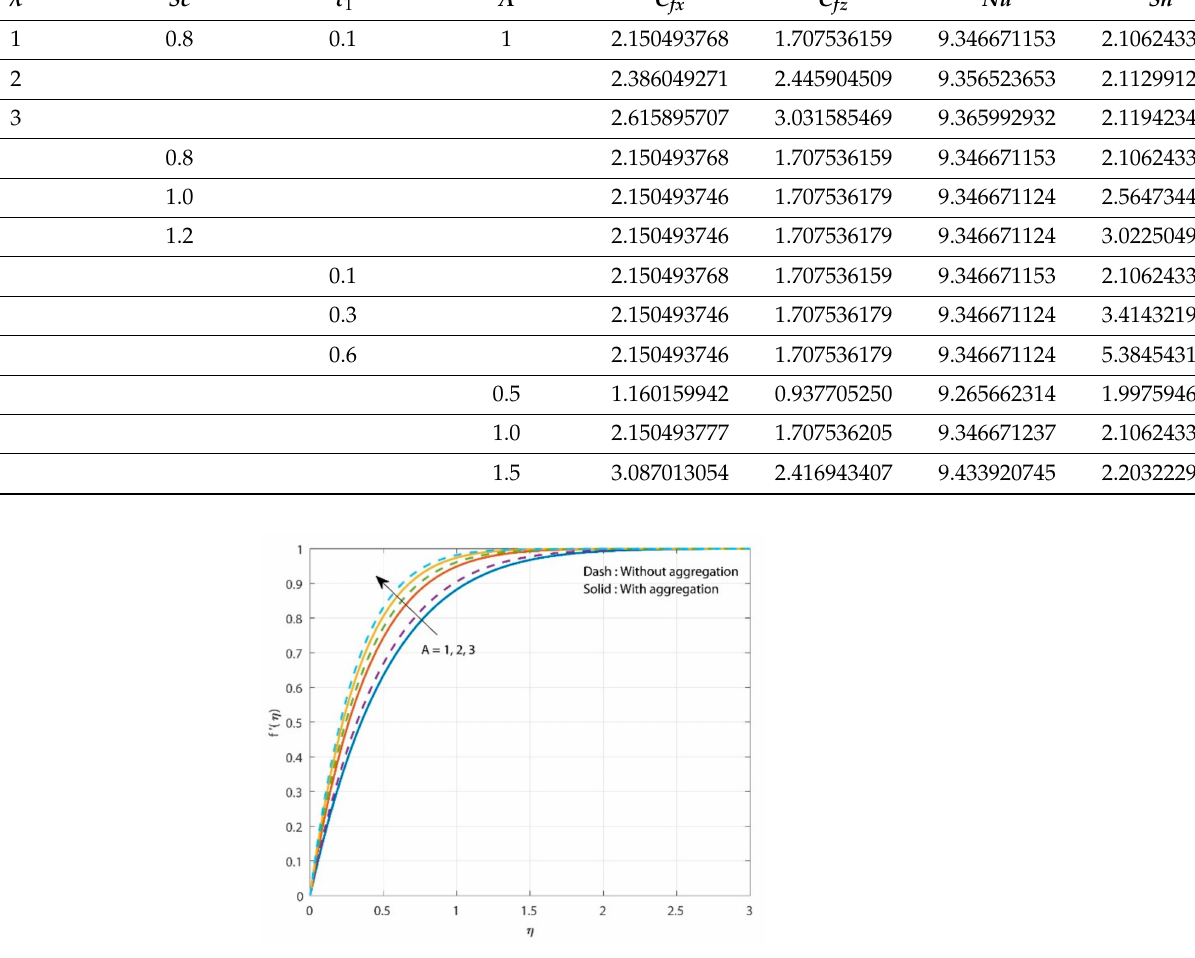
Figure 2. Influence of acceleration parameter on f (cid:48) .